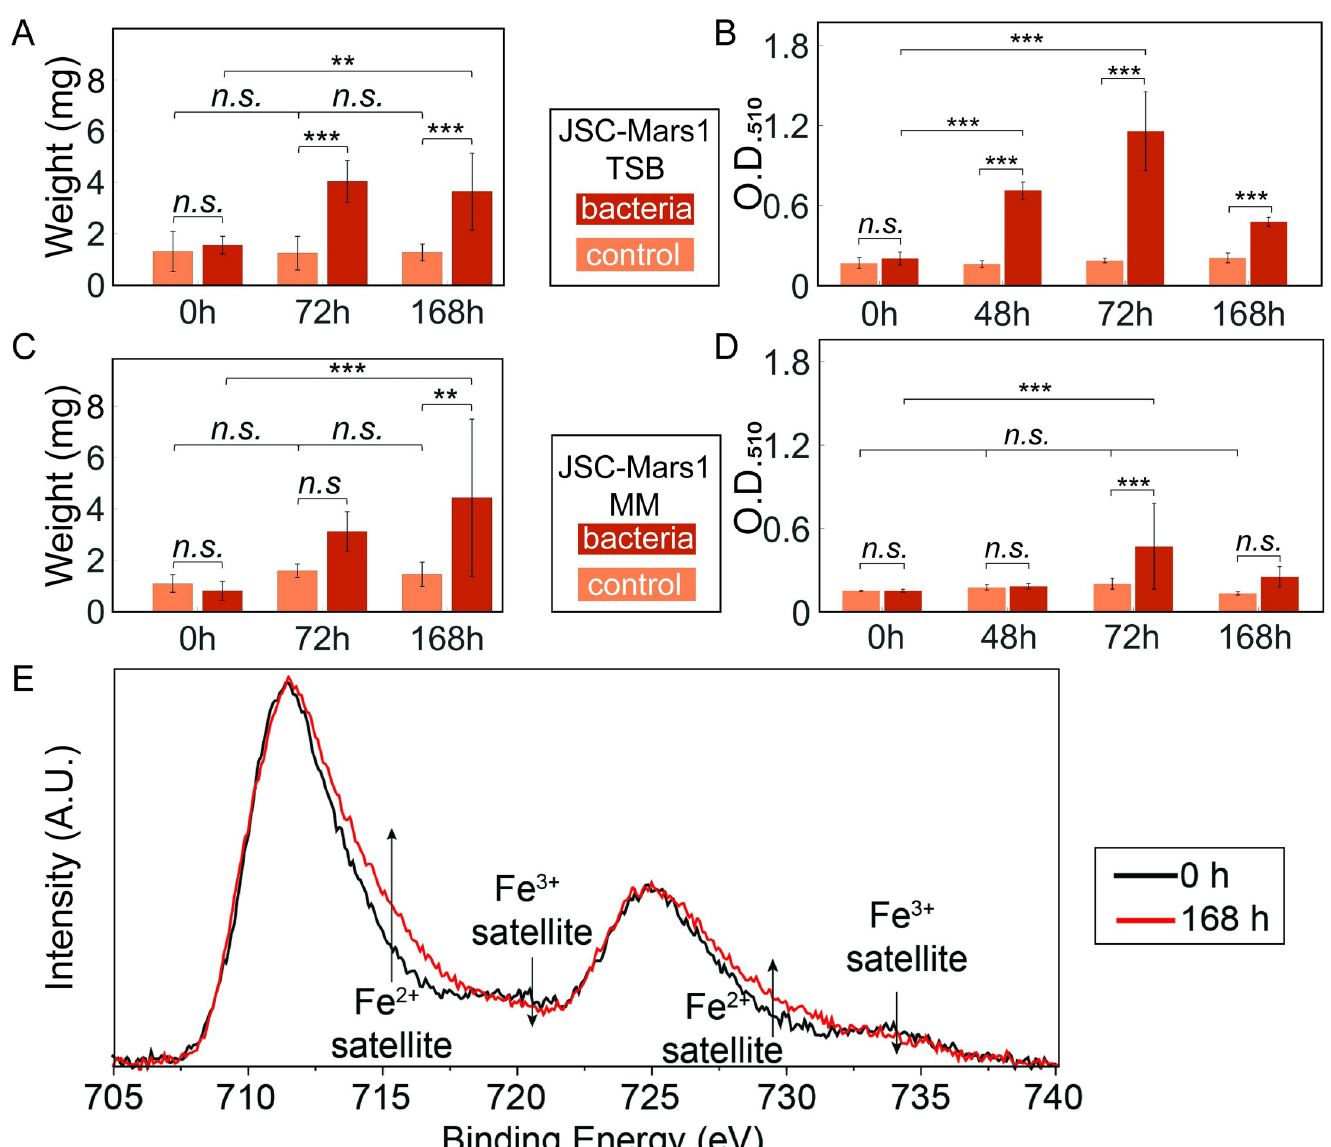
Fig 4. Anaerobic extraction of magnetic material from bacterially treated JSC-Mars1 regolith simulant. The amount of magnetically extracted material from a 10g/L JSC-Mars1 regolith simulant anaerobically incubated with (red) or without (orange) Shewanella bacteria in TSB medium (A) or defined minimal medium (MM) (C) after 0h, 72h, and 168h. The O.D. 510 values of the colorimetric assay to determine the Fe(II) (aq) concentration of 10 g/L JSC-Mars1 regolith anaerobically incubated with (red) or without (orange) Shewanella bacteria in TSB medium (B) and defined minimal medium (D). The standard deviation is given for all bar plots (One-way ANOVA with Tukey PostHoc test: N.s. > 0.05; � � 0.05; �� � 0.01; ��� � 0.001). (E) X-ray photoelectron spectroscopy of iron in JSC-Mars1 regolith samples. A change is visible in the Fe(II) and Fe(III) satellite peaks between the 0h (black line) and the 168h (red line) timepoints of incubation with S . oneidensis